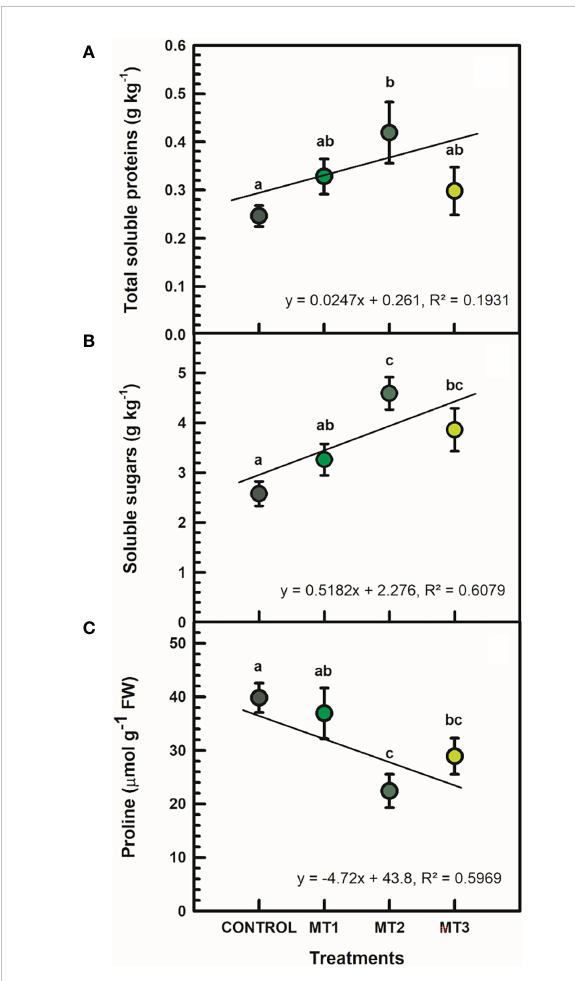
FIGURE 3 Total soluble protein (TSP) ( A ; g kg-1), soluble sugars (SS) ( B ; g kg-1), and proline contents ( C ; mmol g-1 FW) in leaves of tuberose plants treated with preharvest foliar applications of distilled water (control; MT0) and three concentrations of melatonin (MLT): 0.05 mM (MT1), 0.07 mM (MT2), and 1 mM (MT3). Data are means ± SE (n = 40). Different letters above the bars indicate signi fi cant differences according to the LSD test at P = 0.05.